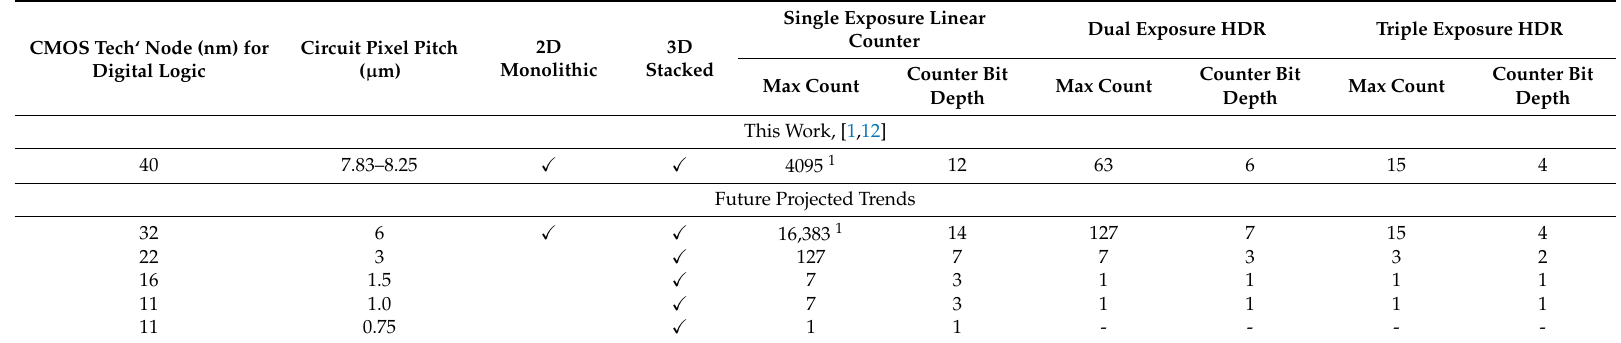
Table 5. Projected pixel shrink trends, of 2D monolithic and 3D-stacked SPAD photon counting pixels based on an all-digital ripple counter architecture, towards 3D-stacked SPAD or Avalanche based Quanta Image Sensors with multi-megapixel arrays.